Question: Draft a figure caption describing what is shown.
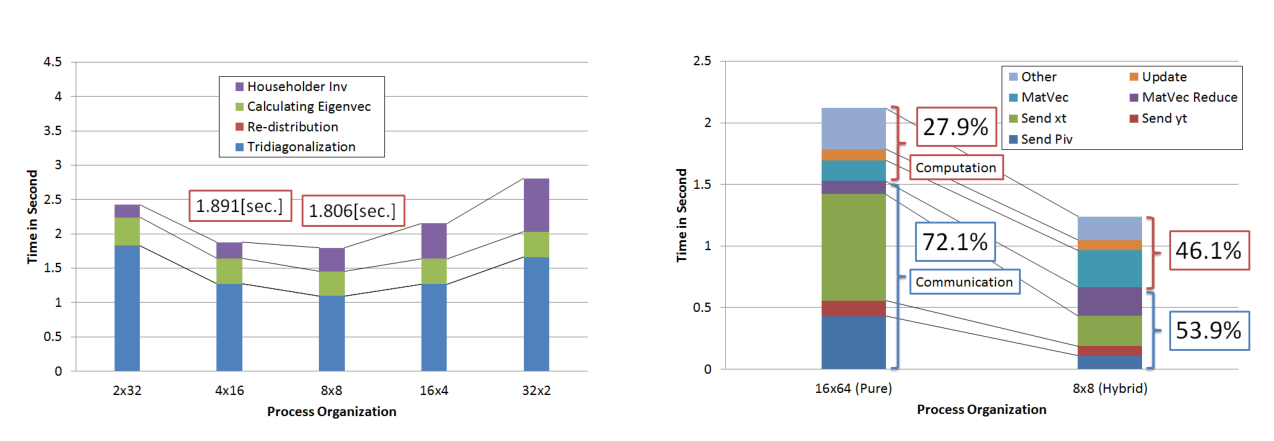
Answer: Comparison of the best pure and hybrid MPI